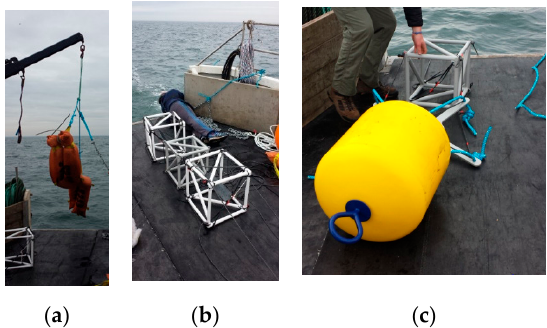
Figure 6. ( a ) Anchors going in, ( b ) Array going in water, ( c ) Submerged buoy being released in water.